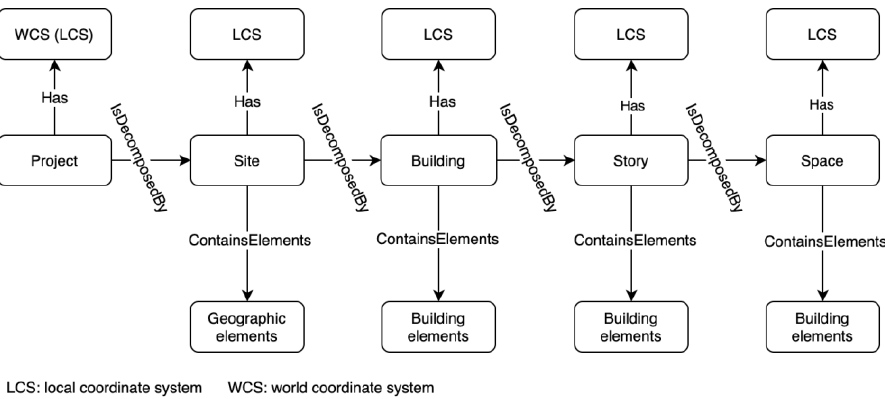
Figure 3. IFC spatial structure elements, i.e., site, building, building story, and space.